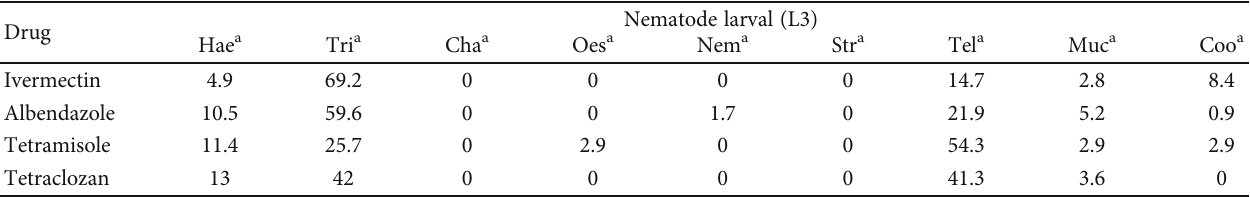
Table 3: Percentage of di ff erent nematode infective larvae identi fi ed based on the morphology of larvae (L3) from coproculture of goats after administration of anthelmintic